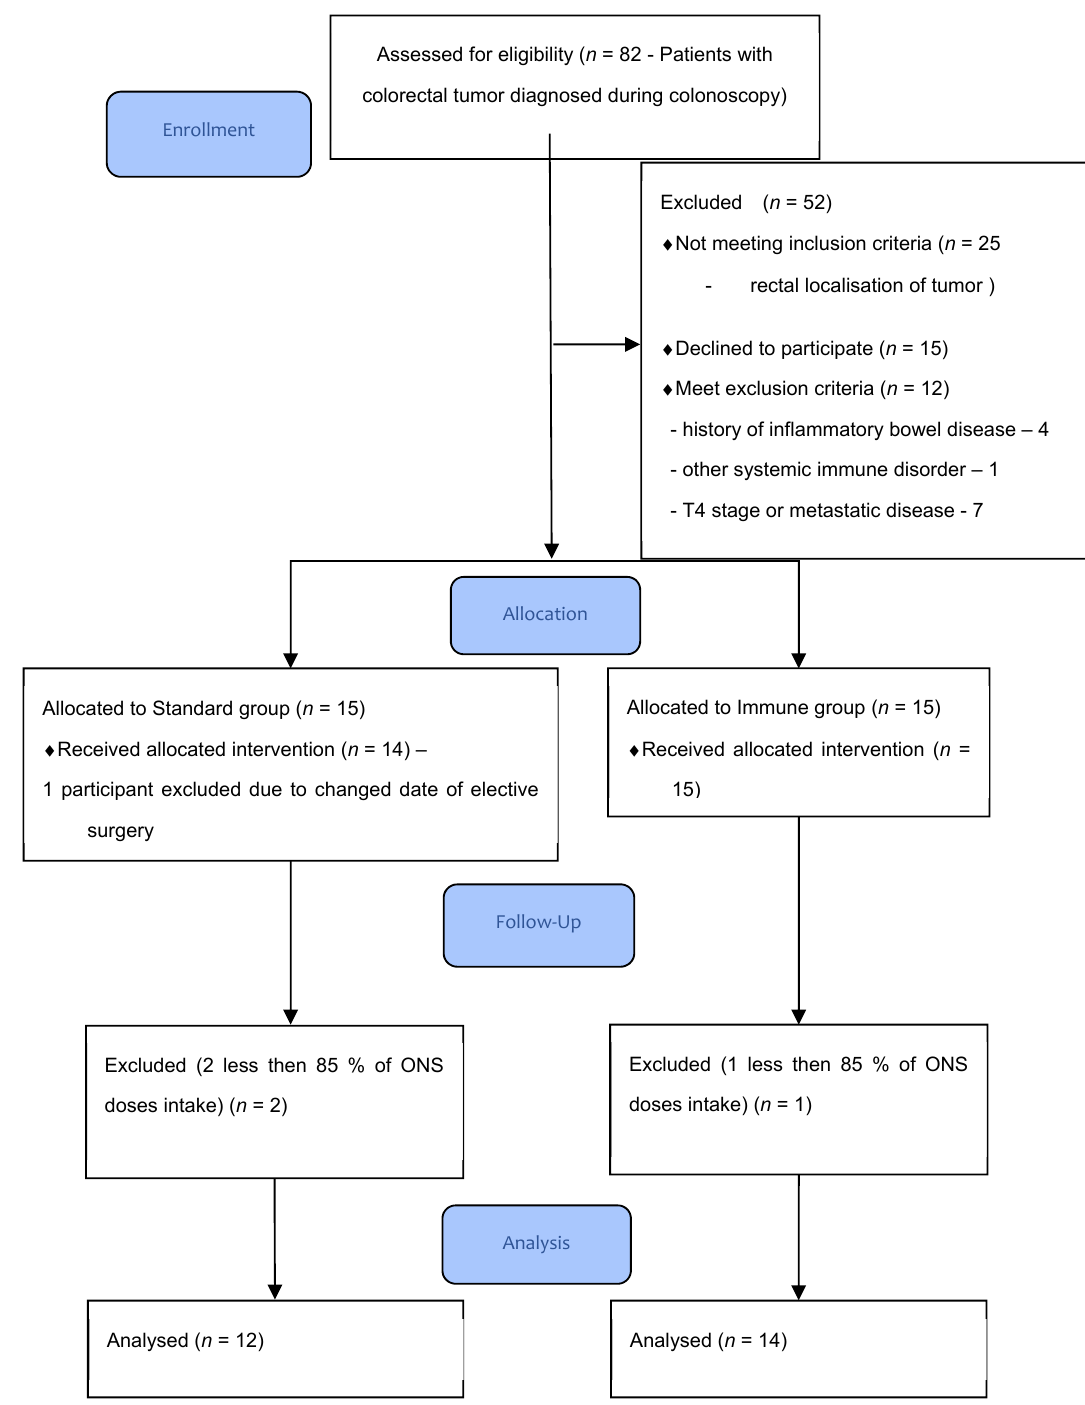
Figure 1. Patients flow-chart.